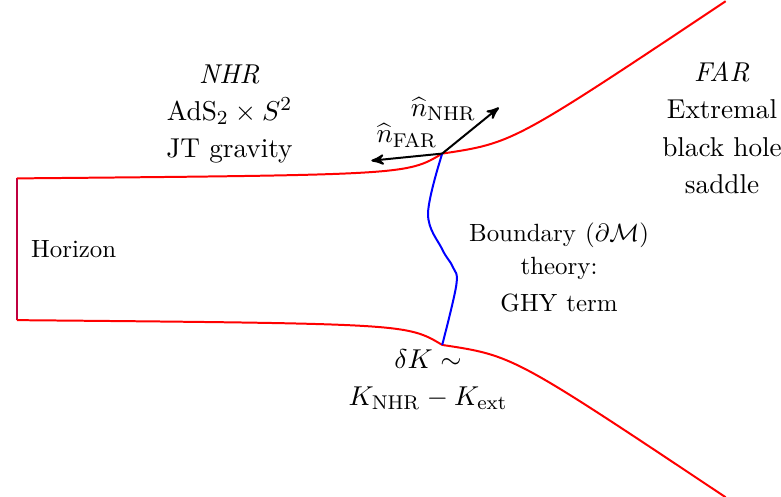
Figure 4. A cartoon of the near-horizon region (NHR) and the far-away region (FAR) separated by a curve along which the boundary term of JT gravity will need to be